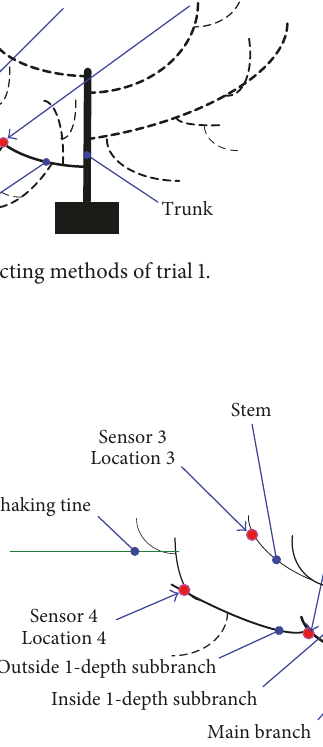
Figure 8: The shaking and detecting methods of trial